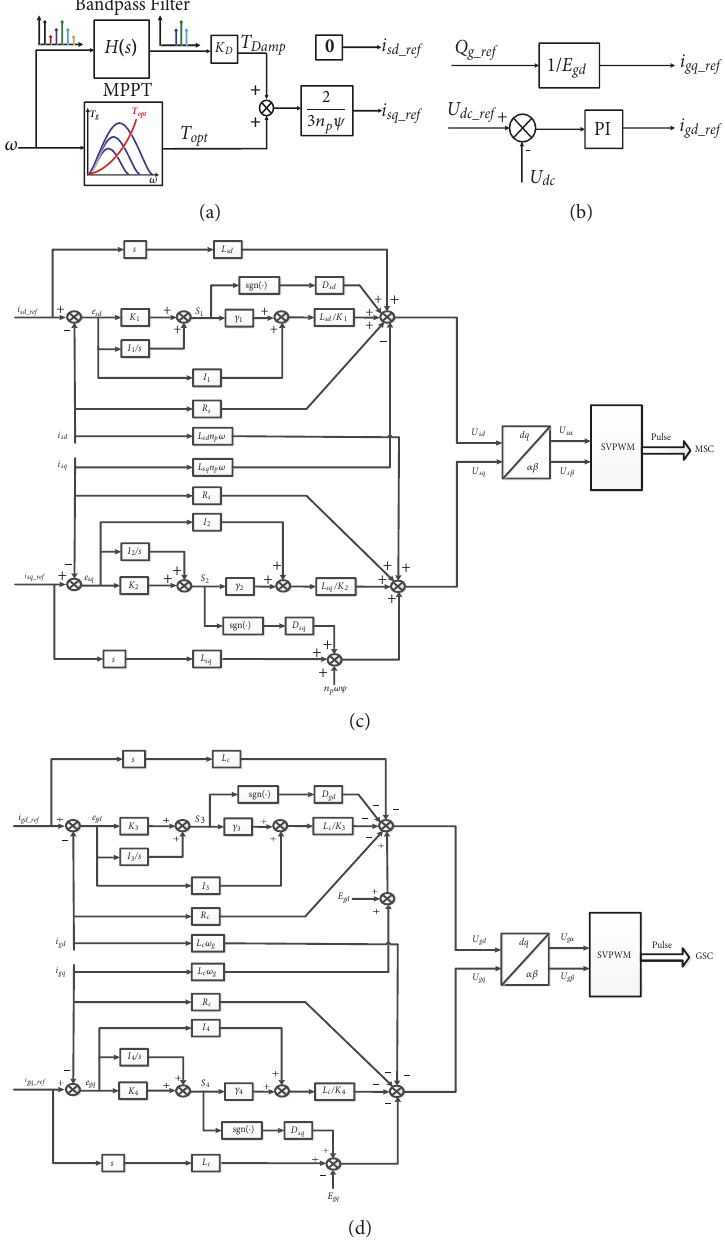
Figure 2: Control structure diagram of